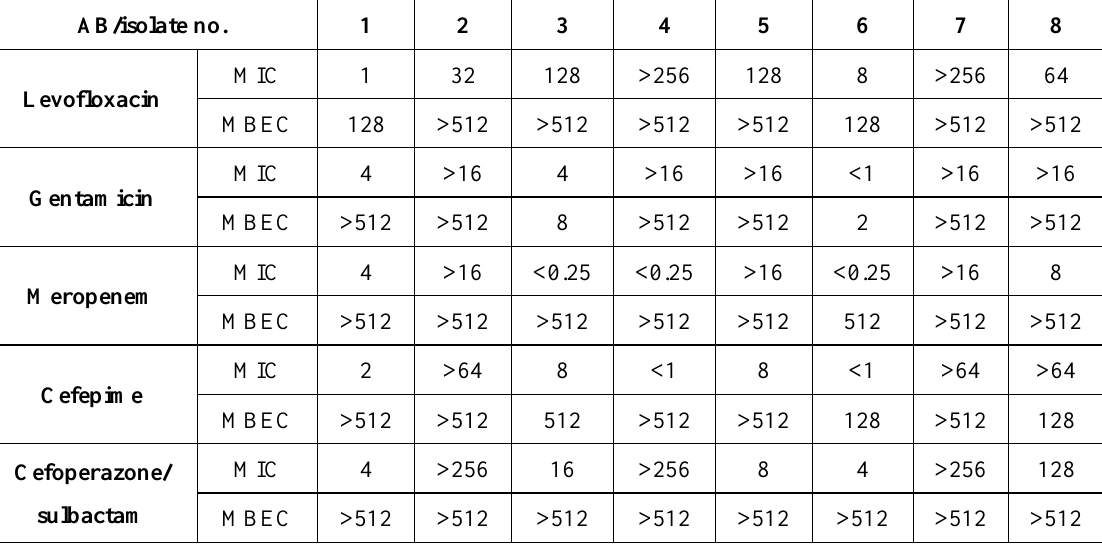
Table 4. Comparison between MIC and MBEC values for each Pseudomonas biofilm forming isolate (n=8). AB/isolate no. Levofloxacin